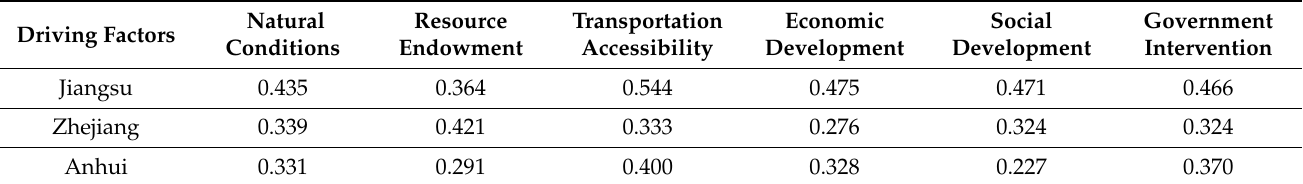
Table 7. Interaction effect detection results of different driving factors in each province of the